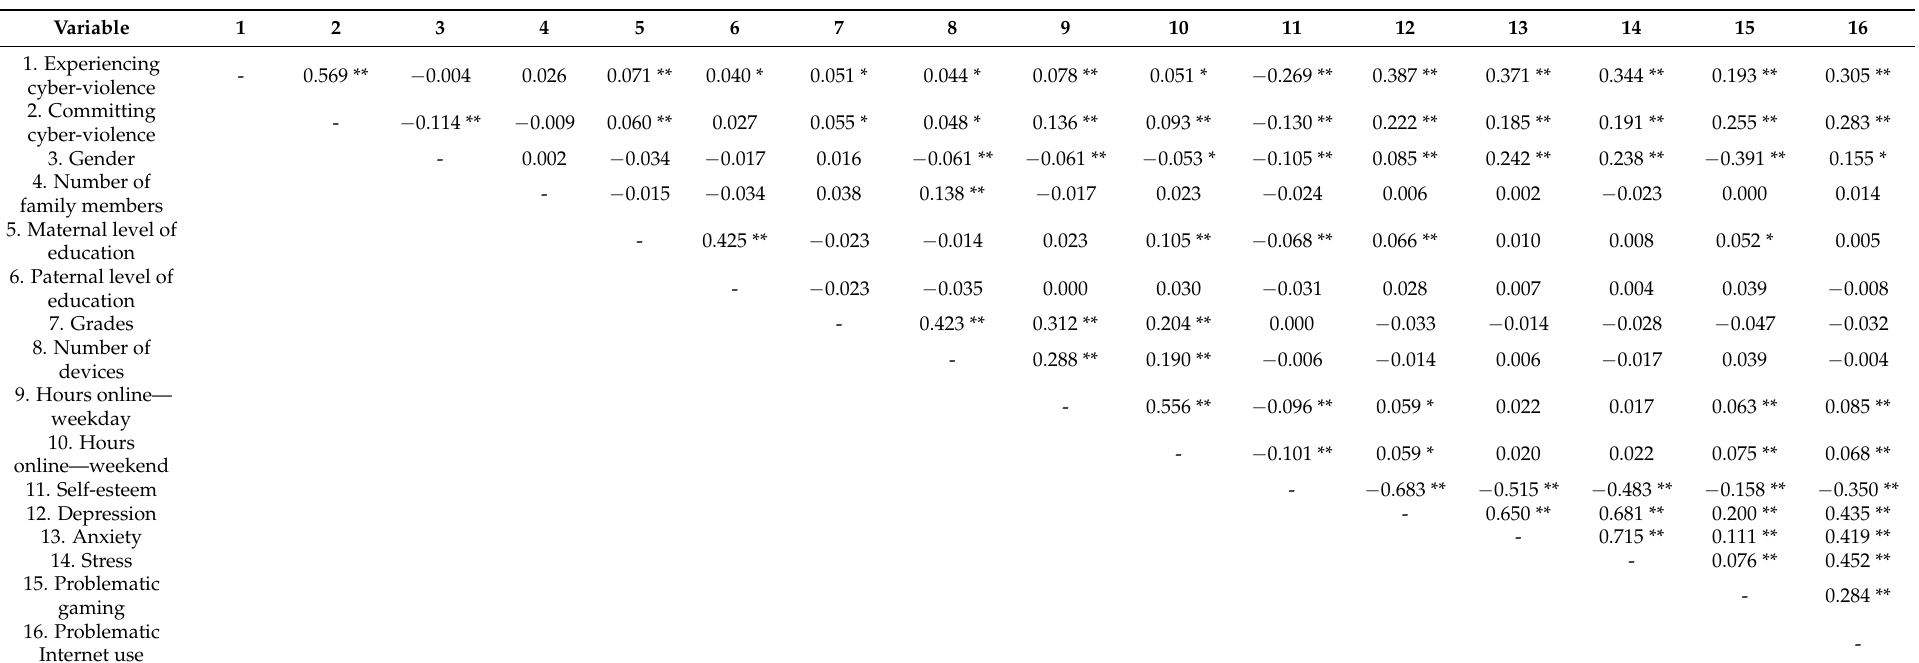
Table 8. Correlations between predictors and predictors with